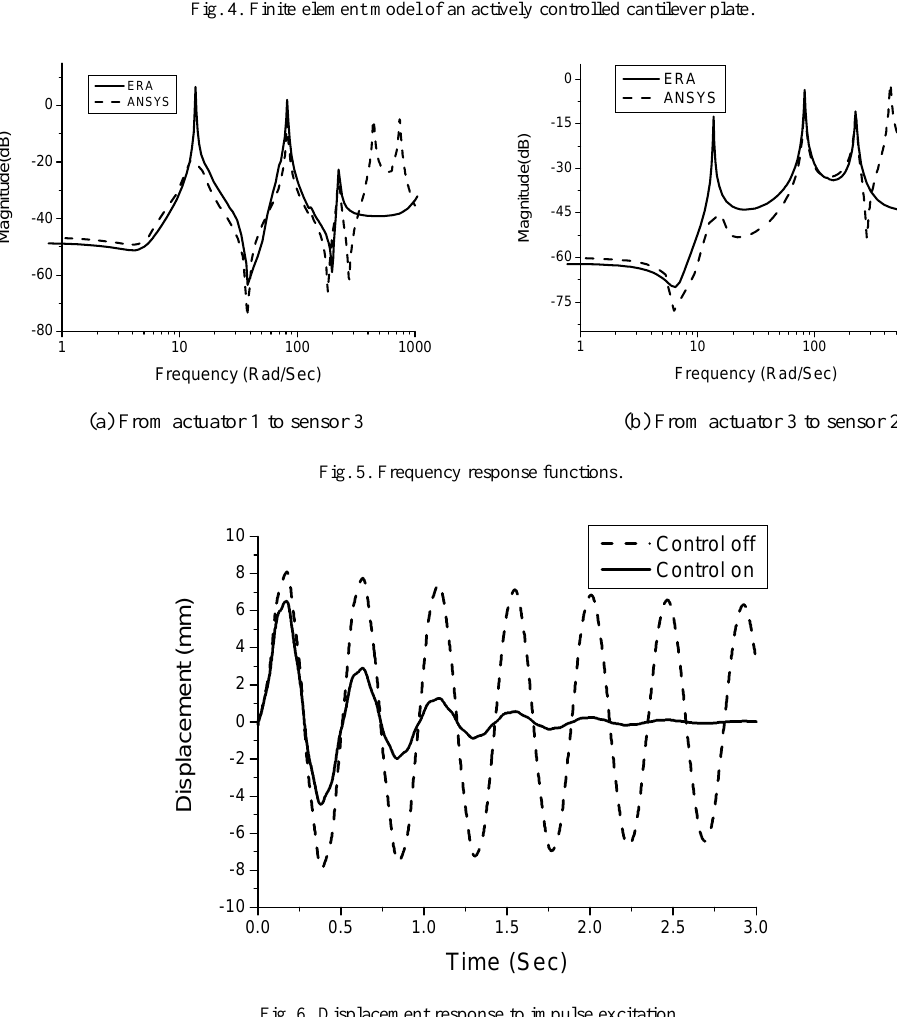
Fig. 4. Finite element model of an actively controlled cantilever plate.